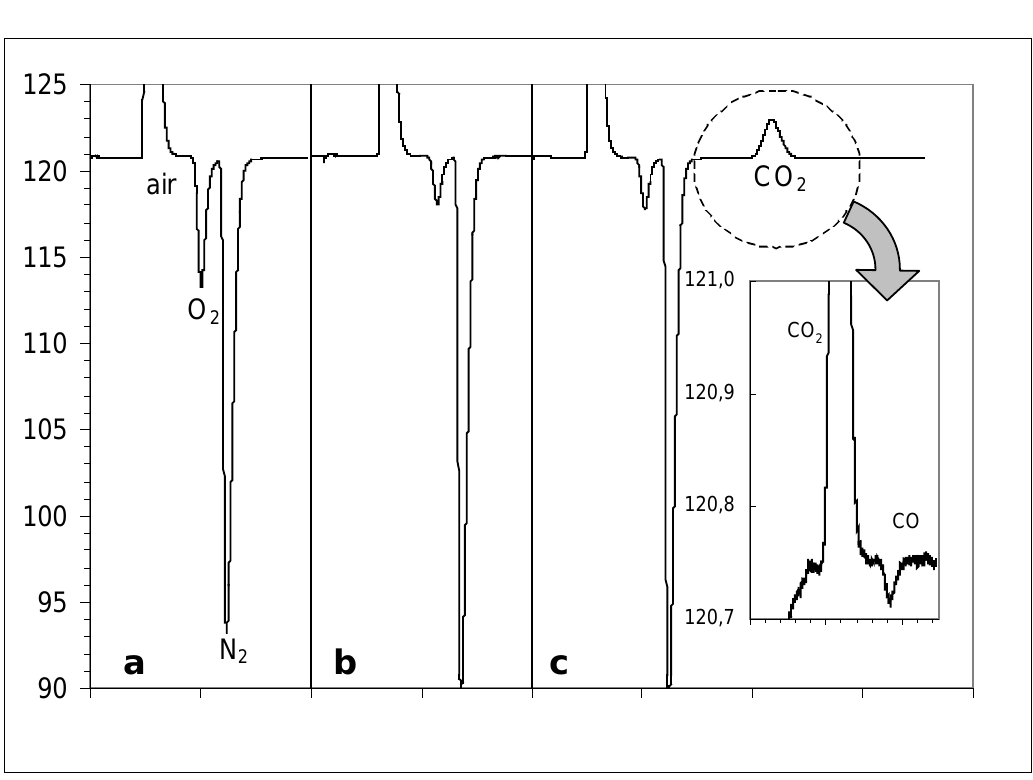
Figure 5. Gas chromatograms of gas phase under quercetin solution during its oxidation by air oxygen in a closed system: (a) – under initial quercetin suspension in the water (pH = 6.56); (b) – under basic solution of quercetin (pH ∼ 11) after 4 days of contacting with air; (c) – after acidification of basic solution up to pH ∼